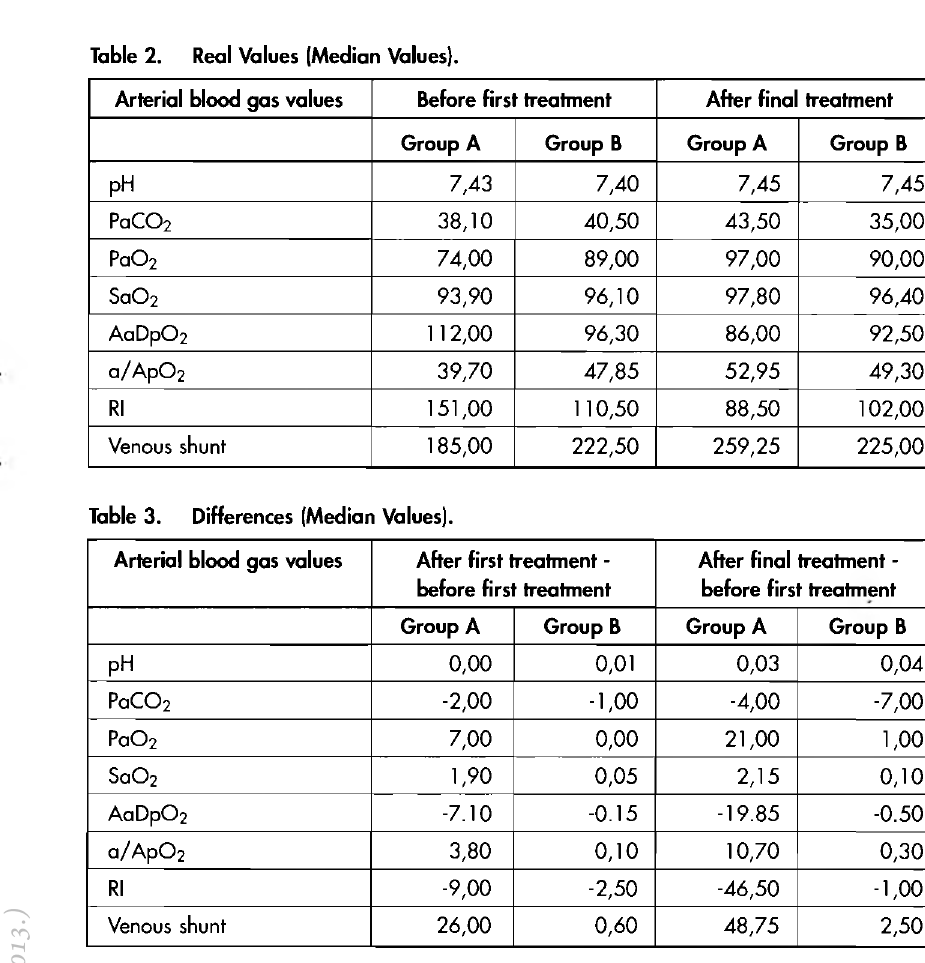
Real Values (Median Values).